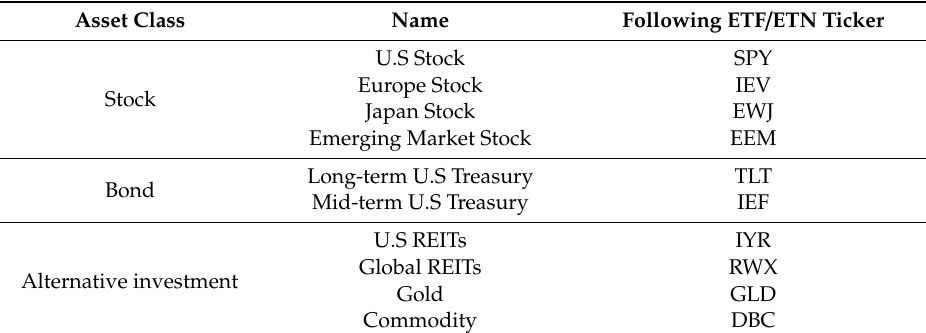
Table 2. Global Asset Allocation Invest Universe (Asset 10).